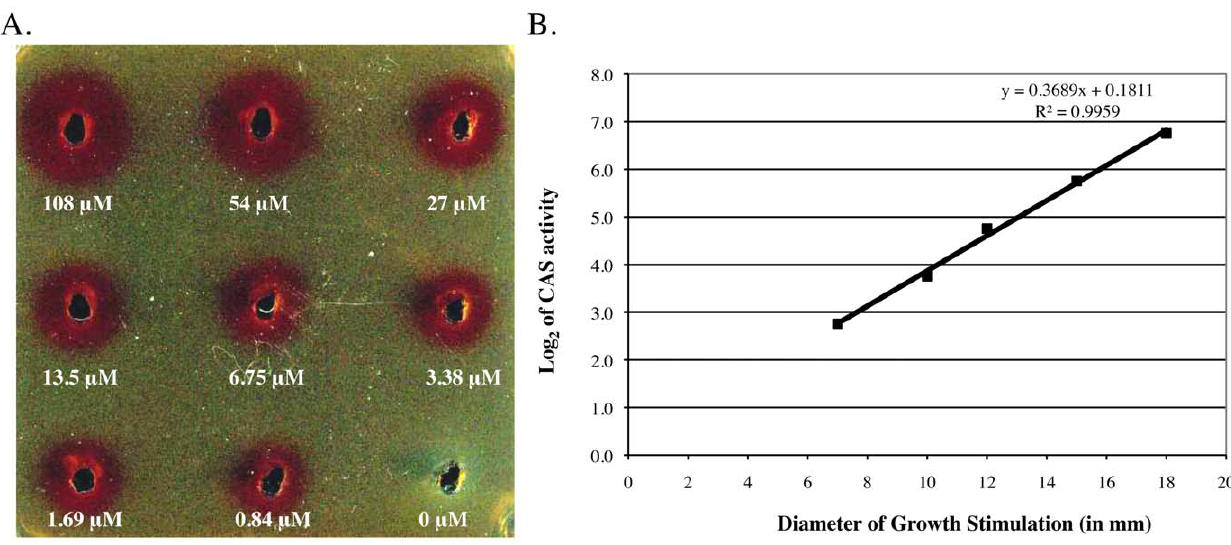
Figure 2. Quantitative bioassay for corynebactin. A. Varying concentrations of corynebactin (expressed as EDDA equivalents) were added to wells containing 25 m M FeCl 3 . Growth of C. diphtheriae C7( b ) D ciuE was stimulated by corynebactin, and the growing bacteria reduced the triphenyltetrazolium chloride indicator dye and turned red. No visible bacterial growth was present around the control well without corynebactin. The figure shows the results of a representative bioassay. B. Within the range from 6.75 m M to 108 m M EDDA equivalents, the average diameter of the growth stimulation zone for C. diphtheriae C7( b ) D ciuE , based on triplicate samples, was directly proportional to the log 2 of the concentration of the corynebactin sample in the well.